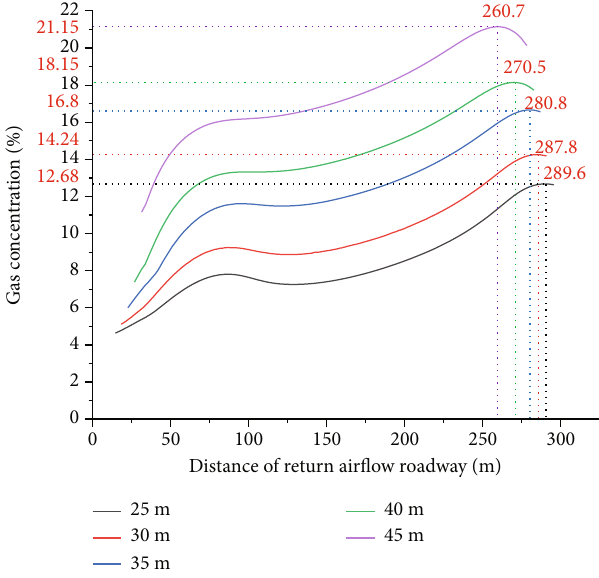
Figure 10: Gas concentration against di ff erent heights at a depth of 45 m in